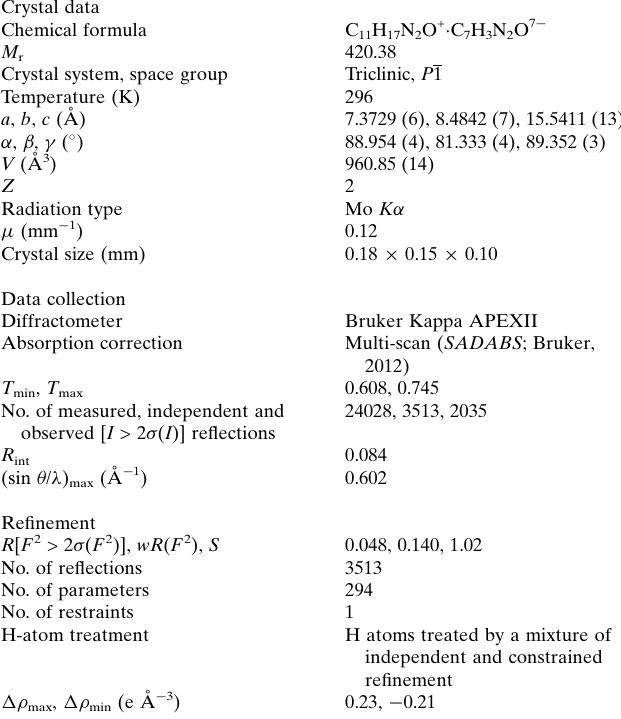
Table 2 Experimental details. Crystal data Chemical